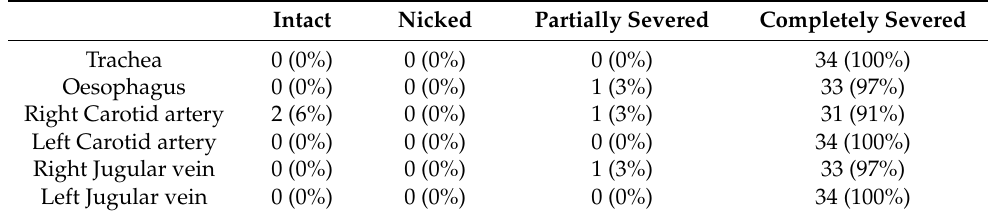
Table 3. Neck pathology of the ducks assessed for loss of behavioral/brainstem responses ( n =